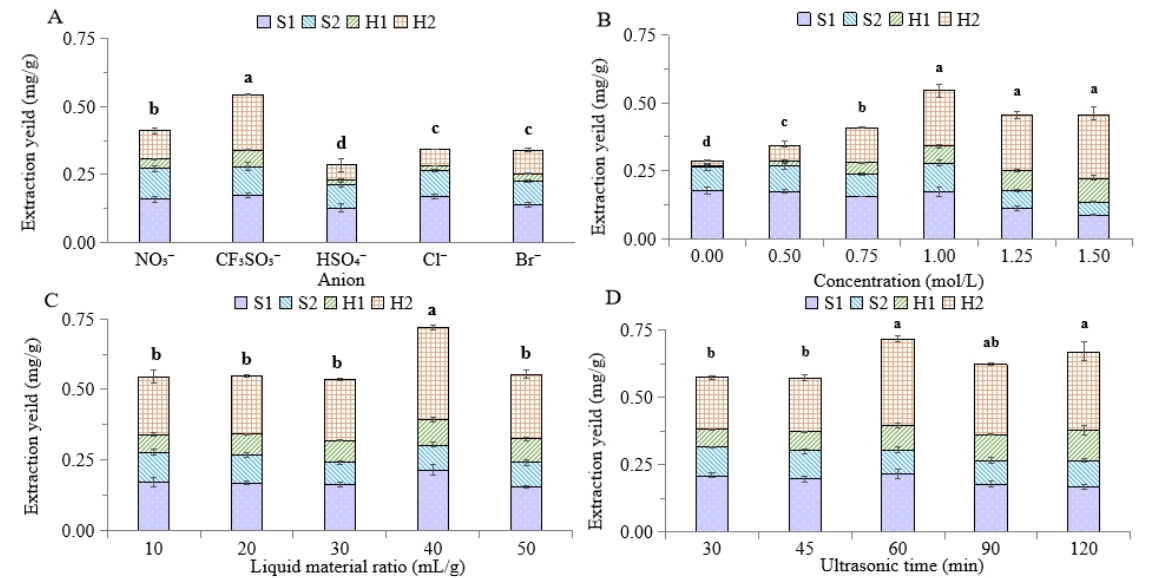
Figure 2. Effect of IL anion ( A ), IL concentration ( B ), liquid-material ratio ( C ), and ultrasonic time ( D ) on extraction yield. Different lowercase letters (a, b, c, d) indicated significant difference in extraction yield between different single factor level (p < 0.05).